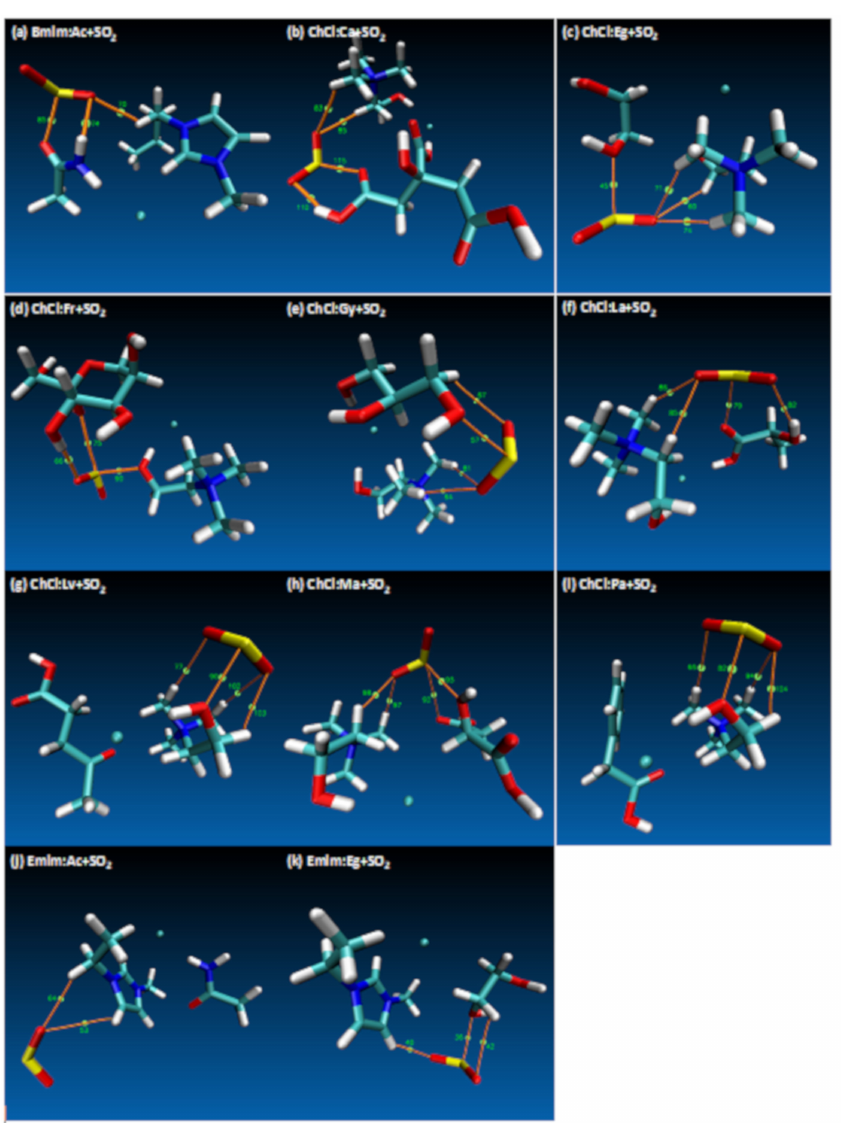
Figure 3. Atom in Molecule (AIM) analysis of interactions and bond critical points (BCP) involving DES + SO 2 systems. Electron density ( ρ ) and Laplacian of electron density ( ∇ 2 ρ ) for displayed BCPs are reported in Table